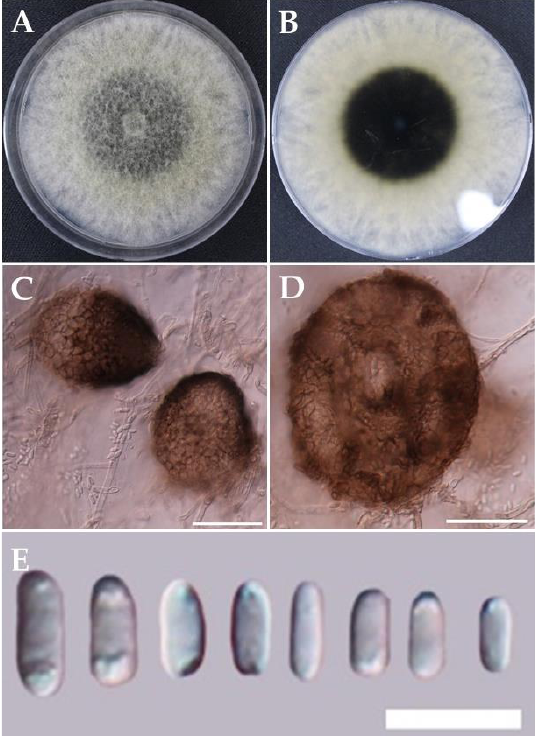
Figure 3. Anterior and posterior view of CMML20 – 2 colony on PDA at 25 °C for 7 days ( A , B ). The structure of pycnidia ( C , D ) and conidia ( E ) formed on PDA observed under the microscope. Scale bars in ( C , D ) = 100 μm, ( E ) = 10 μm.